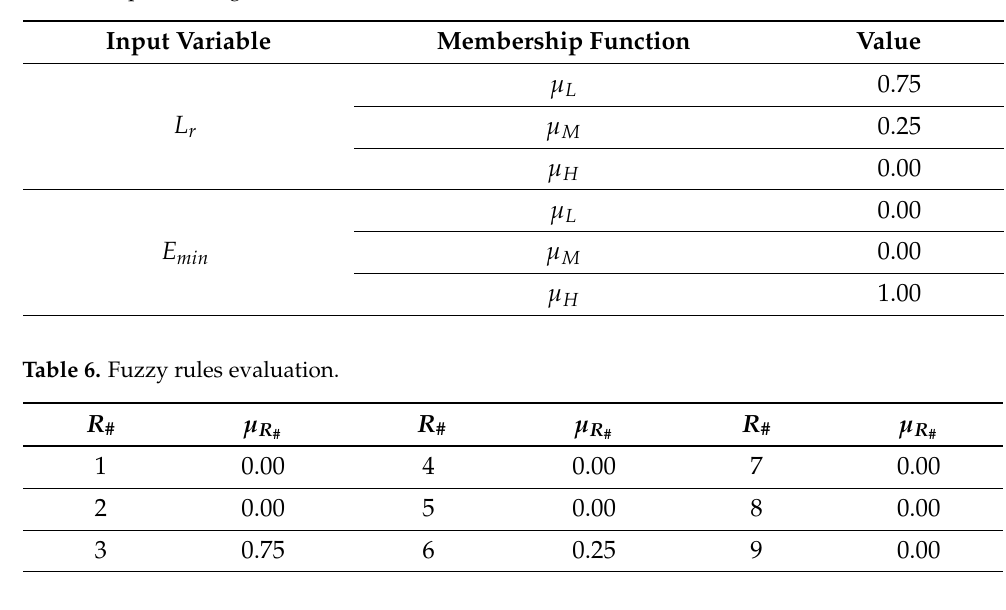
Table 5. Inputs of linguistic variables.